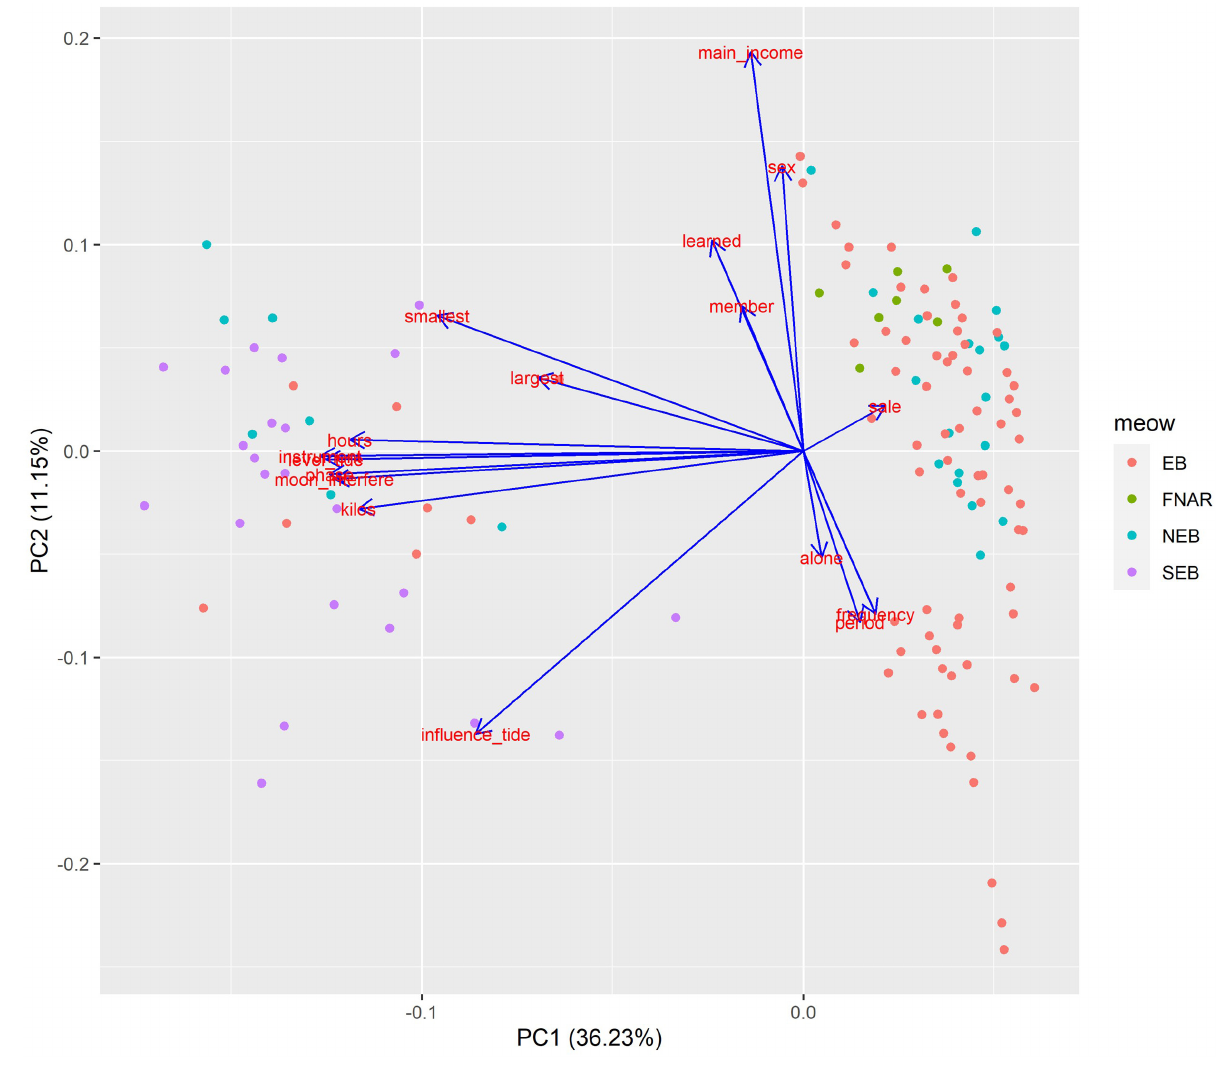
FIGURE 3 | Principal component analysis illustrating the pattern of octopus fishers interviewed along the Brazilian coast, considering the marine ecoregions of the Brazilian coast, according to Spalding et al. (2007): EB, eastern Brazil; FNAR, Fernando de Noronha and Atol das Rocas; NEB, northeastern Brazil; SEB, southeastern Brazil. Description of variables, as in Table 2